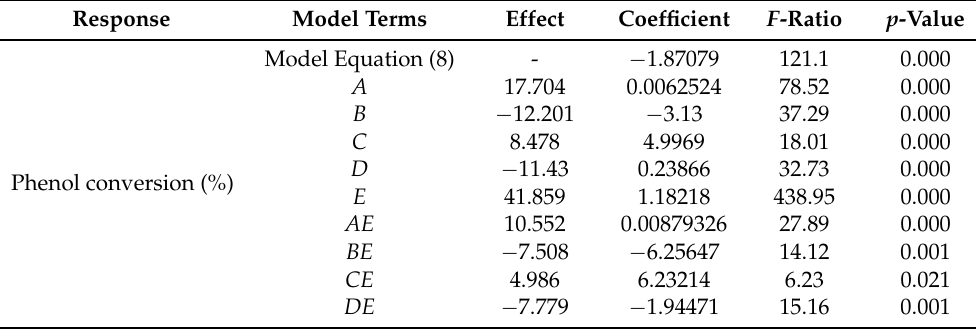
Table 5. The regression coefficient value of the reduced model for Y 1 .